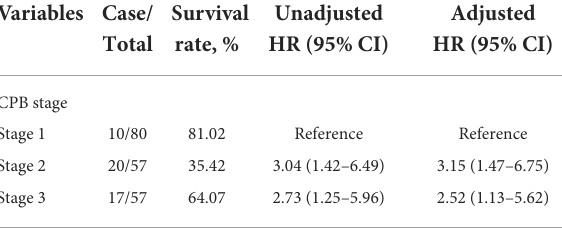
TABLE 7 Effect-size estimates for CPB stage in the validation